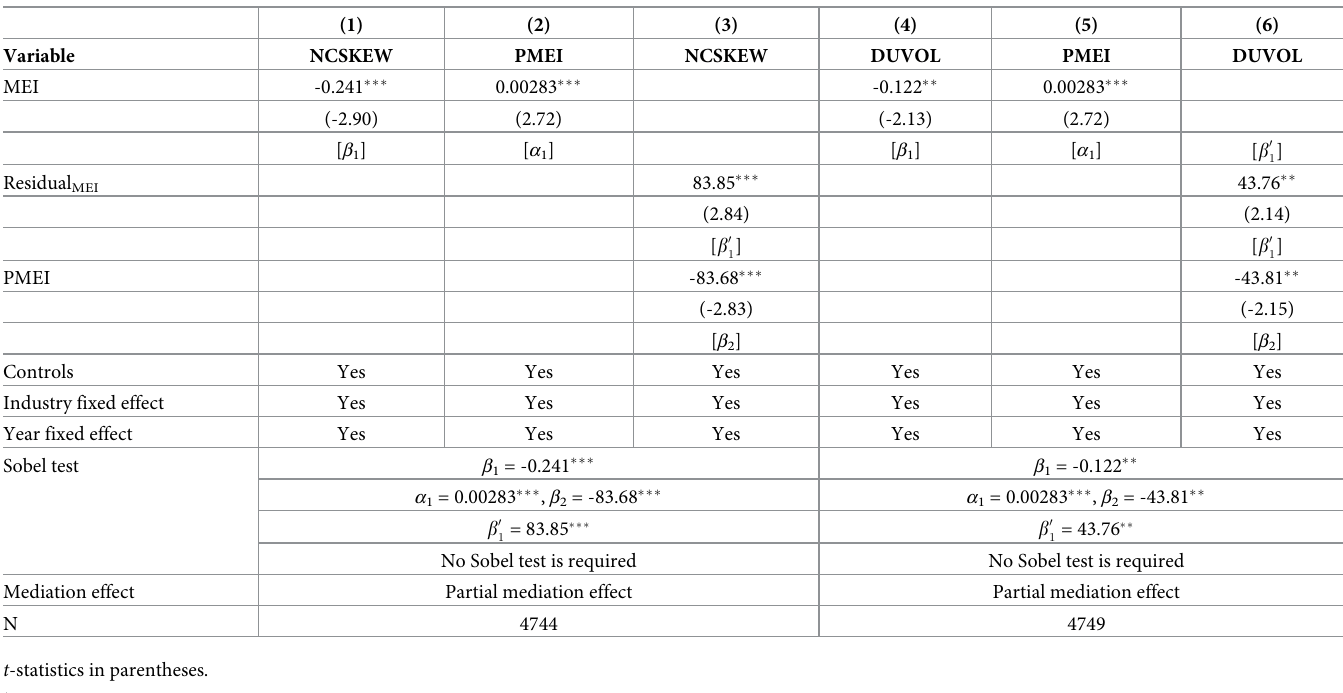
Table 3. Mediation effects